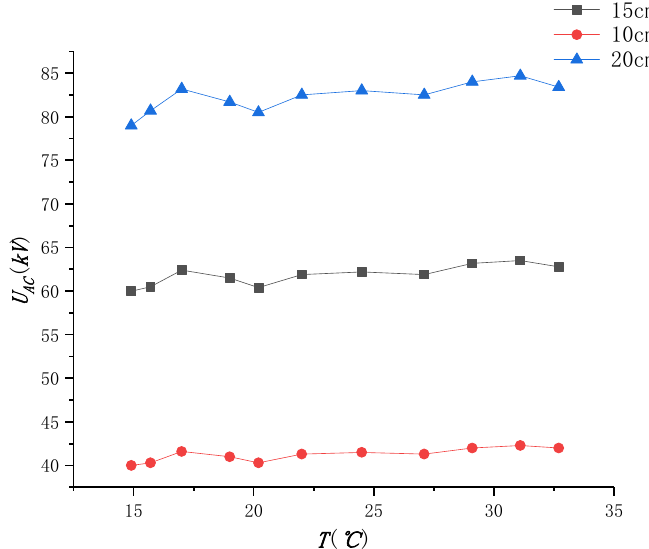
Figure 11. Gap breakdown voltage at different temperatures.